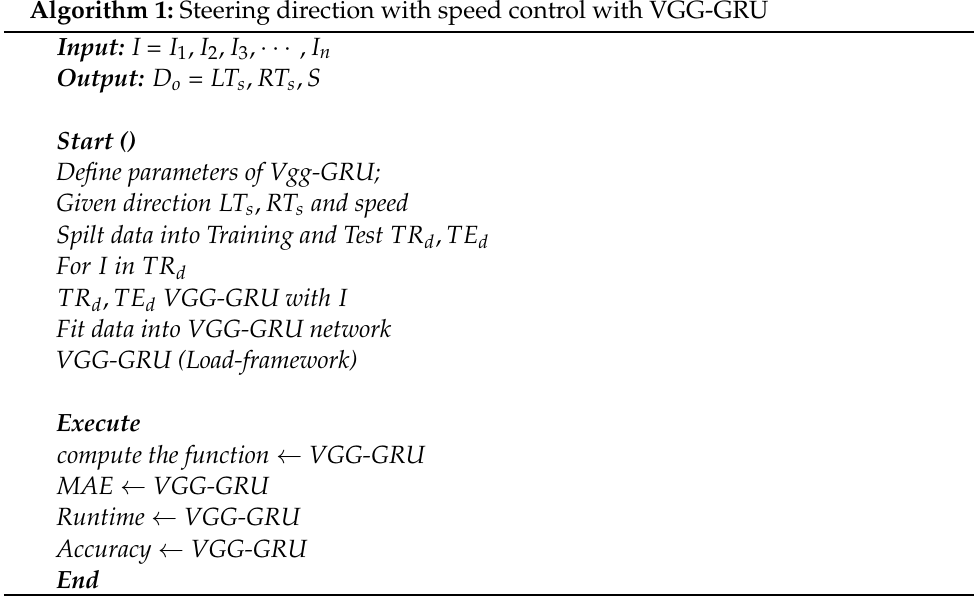
Algorithm 1: Steering direction with speed control with